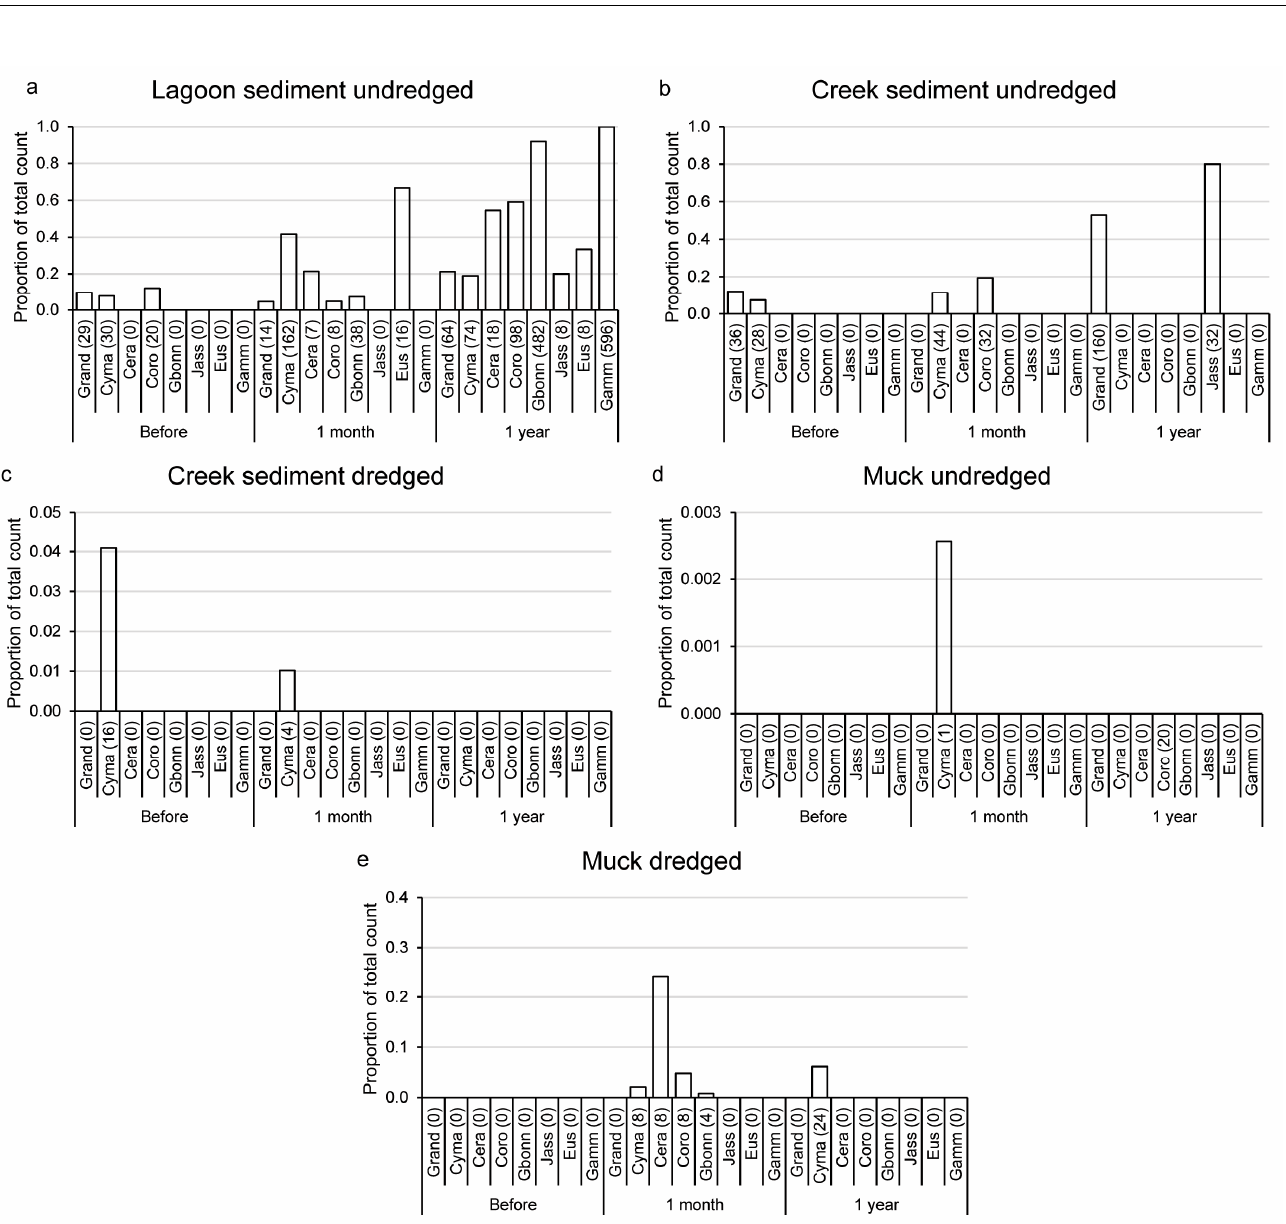
Figure 3. Proportion of each amphipod taxon found in ( a ) sediments in the lagoon that were not muck and were not dredged, ( b ) sediments in the creeks that were not muck and were not dredged, ( c ) sediments in Turkey Creek that were not muck and were dredged, ( d ) sediments in the creeks that were muck and were not dredged, and ( e ) sediments in Turkey Creek that were muck and were dredged, with the number of individuals in parentheses following the taxon. Note the differences in the y-axes. Grand = Grandidierella sp., Cyma = Cymadusa compta , Cera = Cerapus tubularis , Coro = Corophium sp., Gbonn = Grandidierella bonnieroides , Jass = Jassa sp., Eus = Eusirus cuspidatus , and Gamm = Gammarus mucronatus .